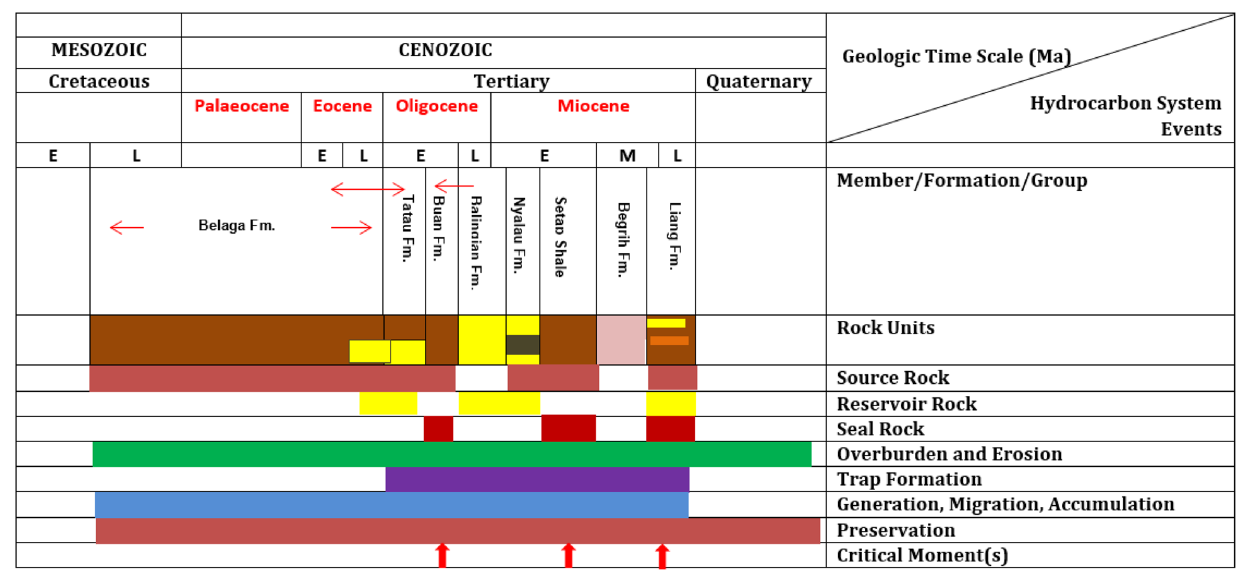
Fig. 7 Constructed petroleum systems event chart for the Sarawak onshore. Identification critical moments was based on chronological ordering of key petroleum system’s elements that is suitable for hydrocarbon